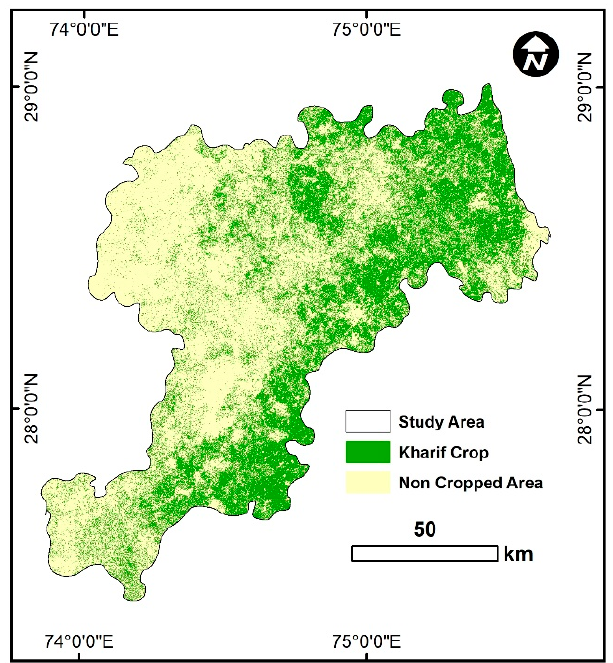
Figure 7. Kharif crop distribution (Datum: WGS84).